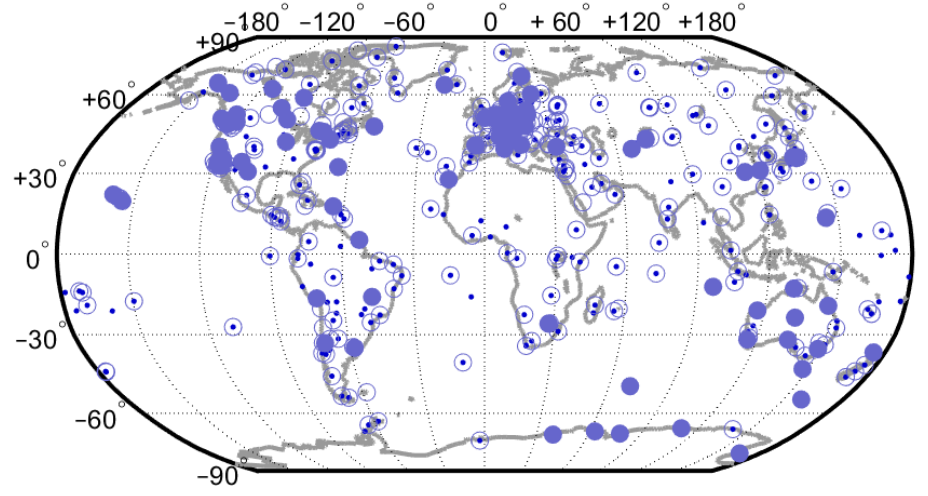
Figure 1. Map of the GNSS stations available from the two reprocessed data sets: IGS repro1 (empty circles), CODE REPRO2015 (small dots), and the 81 common stations (full circles) used in this